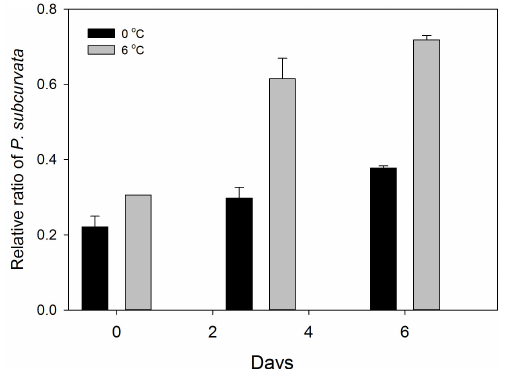
Figure 3. The C:Chl a ratios of Pseudo-nitzschia subcurvata and Phaeocystis antarctica from the thermal response curves shown in Fig. 1 for a range of temperatures from 0 to 10 ◦ C. Values repre- sent the means and error bars represents the standard deviations of triplicate samples.